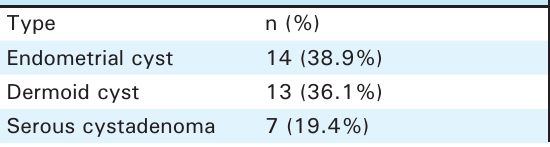
Table 1. (cid:2)(cid:3)(cid:4)(cid:3)(cid:5)(cid:6)(cid:7)(cid:8)(cid:6)(cid:4)(cid:9)(cid:8)(cid:10)(cid:11)(cid:12)(cid:13)(cid:9)(cid:12)(cid:14)(cid:7)(cid:10)(cid:6)(cid:15)(cid:10)(cid:16)(cid:17)(cid:18)(cid:10)(cid:6)(cid:19)(cid:3)(cid:5)(cid:9)(cid:3)(cid:12)(cid:10)(cid:16)(cid:20)(cid:21)(cid:6)(cid:5)(cid:7)(cid:10) (n=36).